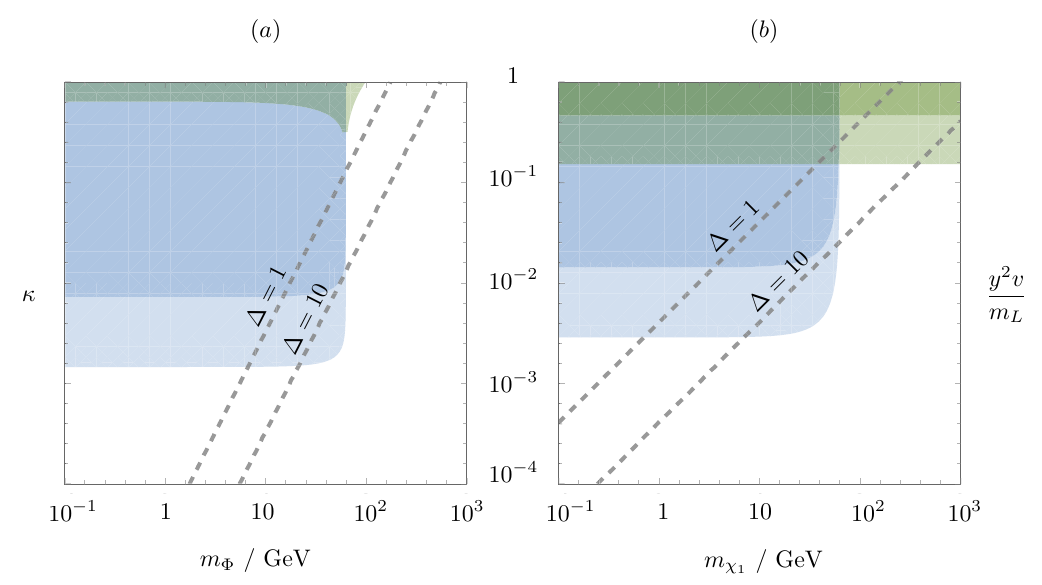
Figure 1 . ( a ) Constraints on the parameter space of the scalar model as a function of m Φ and κ coming from the current upper bound BR( h invisible) < 20% (dark blue), as well as the → BR( h invisible) < 1% region that will be accessible in the near future (light blue). The light → green region denotes the parameter space accessible by a percent-level measurement of the hZ cross section achievable at future lepton colliders. The dashed lines correspond to ∆ = 1 , 10. ( b ) Constraints on the parameter space of the fermionic model as a function of m χ and y 2 v/m L in the 1 m L coming from the current upper bound BR( h invisible) < 20% (dark blue), as limit m N , v (cid:30) → well as the BR( h invisible) < 1% region that will be accessible in the near future (light blue). → The dark green region denotes the 2 σ exclusion from current bounds on the T parameter, while the light green region denotes the potential exclusion from bounds on the T parameter achievable at future lepton colliders. The dashed lines correspond to ∆ = 1 ,